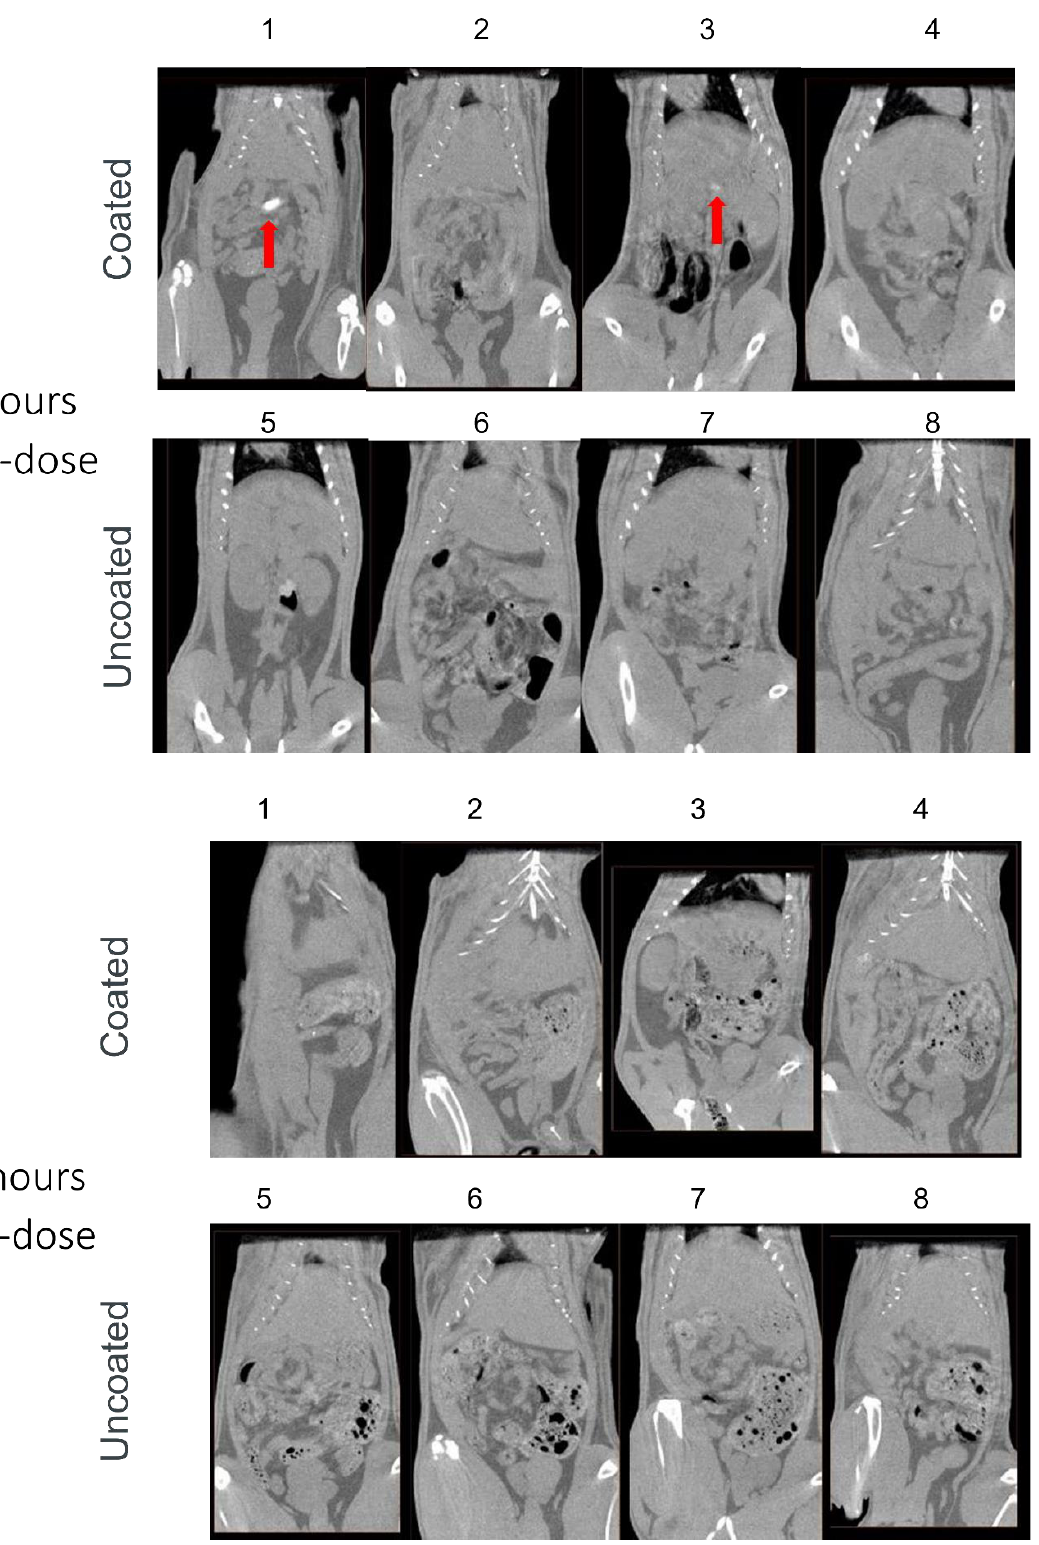
Figure 2. Computed tomography (CT) images captured immediately and 3, 7, and 24 h after administration of Phloral ® -coated and uncoated capsules to rats ( n = 4 each group; rats 1 – 4 received coated capsules, rats 5 – 8 received uncoated capsules). Contrast demonstrating the presence of intact/partially intact capsules in the stomach or intestines is indicated with red arrows.